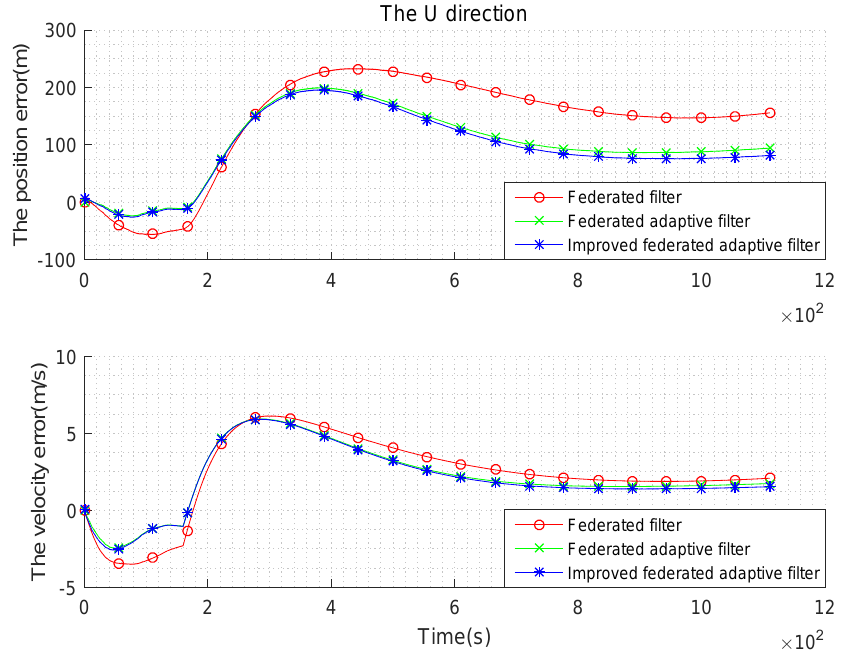
Figure 12. Comparison of the navigation error with non-Gaussian state noise and biased estimation in U direction.